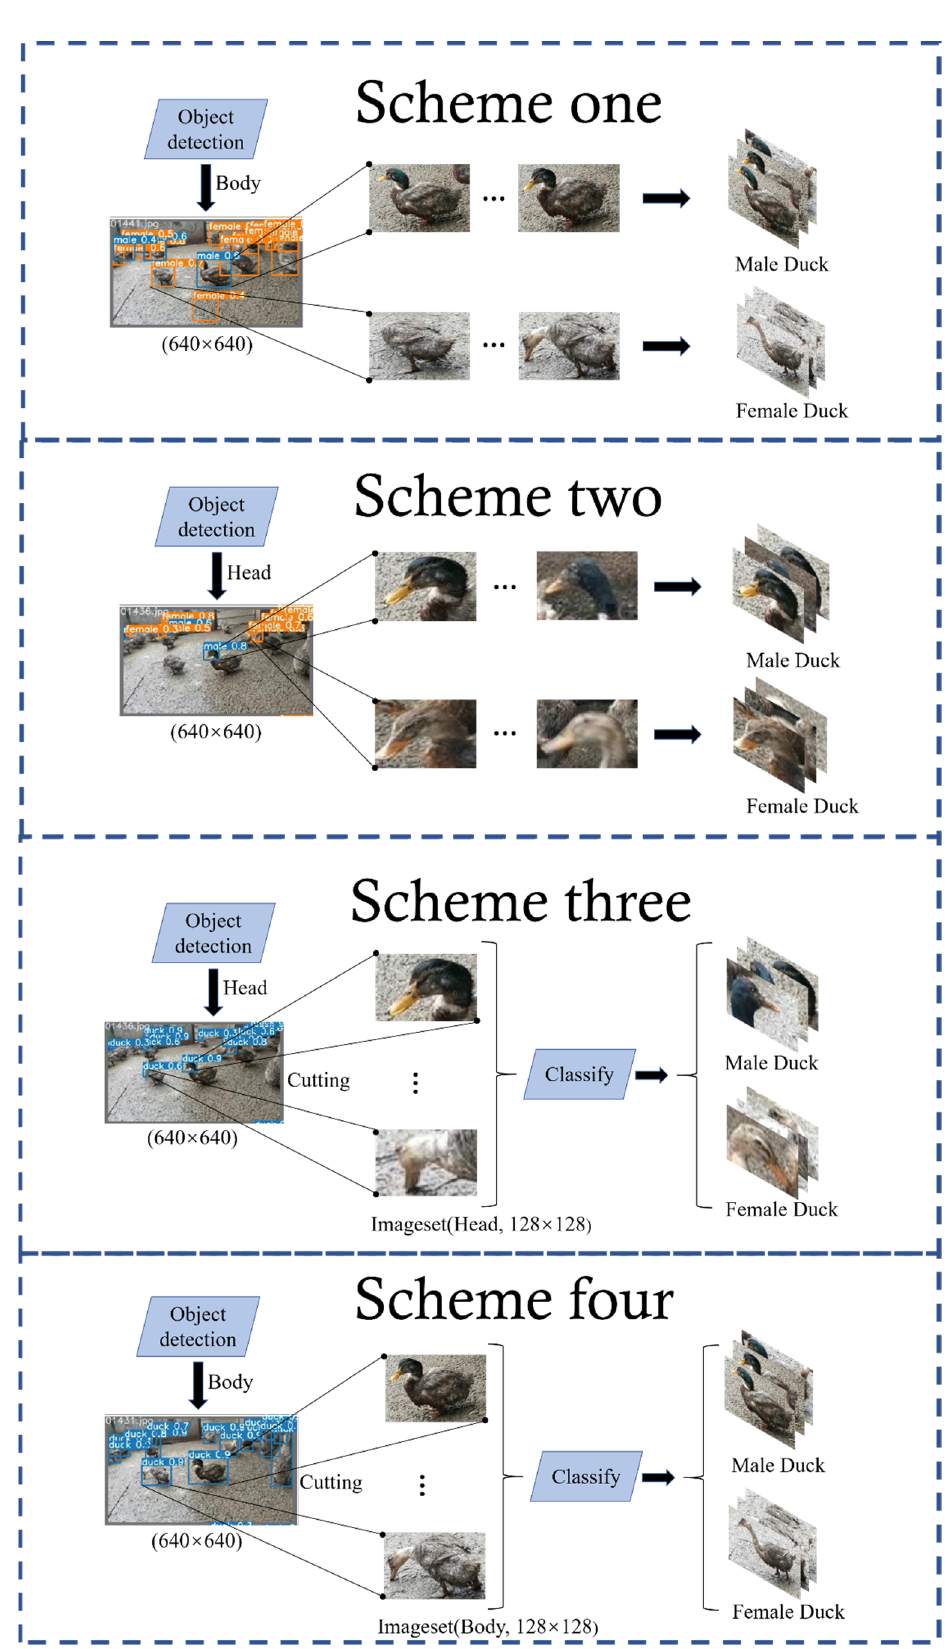
Figure 13. Flow chart of four schemes.